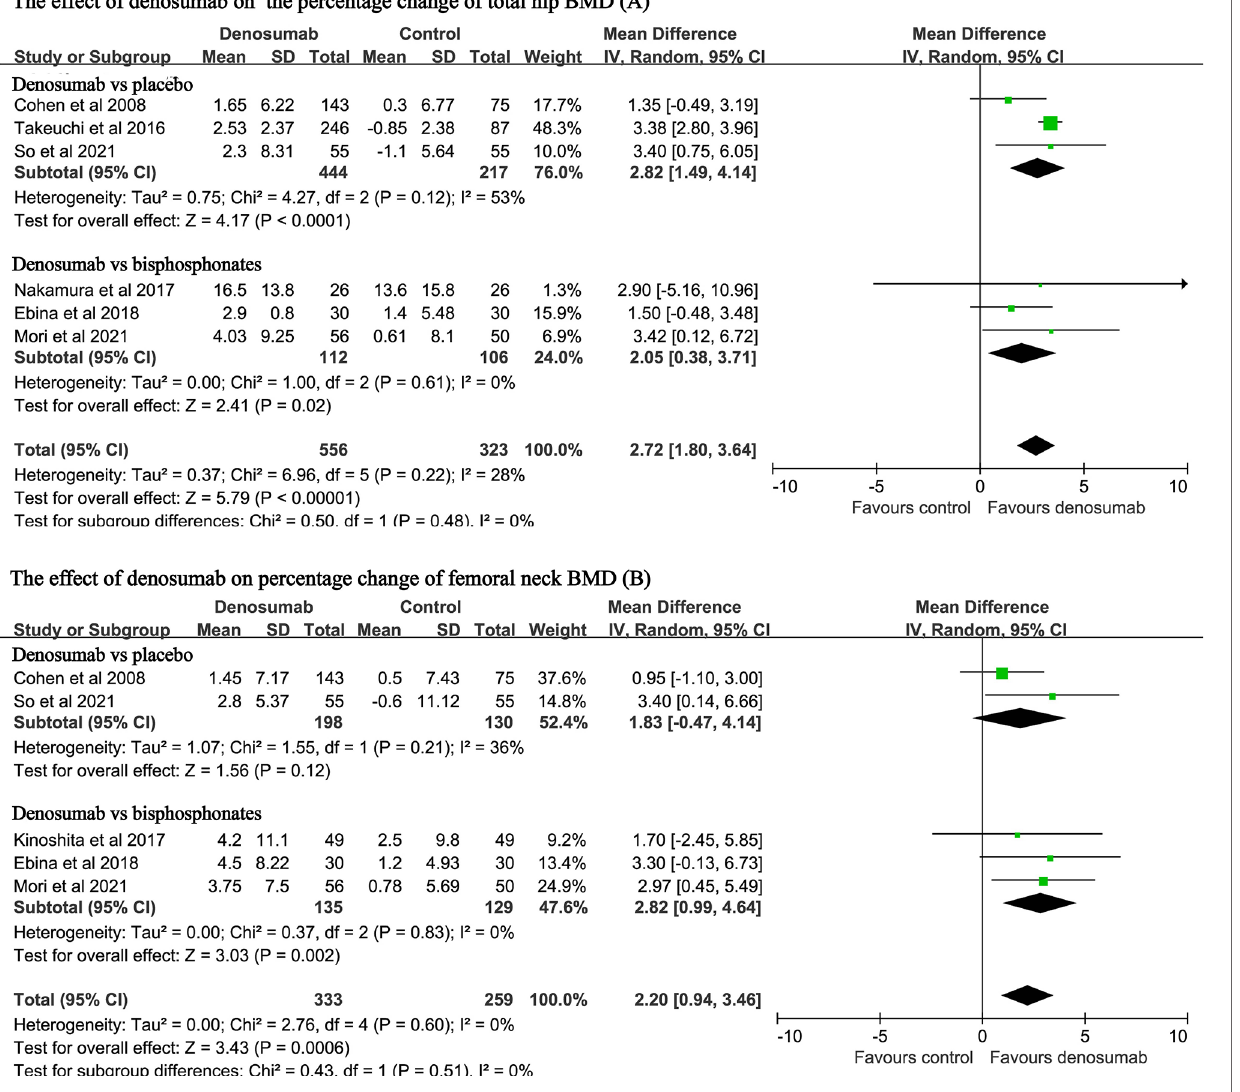
FIGURE 3 | Forest plot for the effect of denosumab on the percent changes in total hip BMD (A) and femoral neck BMD (B)